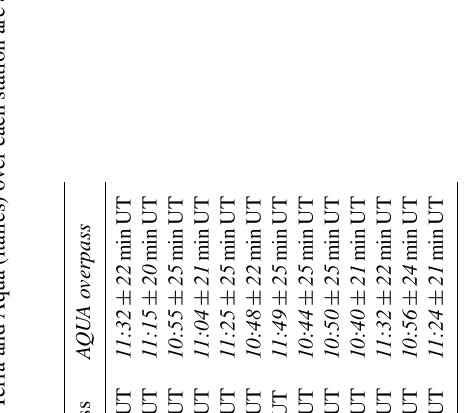
Figure 1. Eastern Mediterranean map with the nine subregions se- lected for the generalization of our results and the location of the AERONET stations used for the validation of MODIS satellite data. The nine subregions are NBL (northern Balkans land), SBL (south- ern Balkans land), ANL (Anatolia land), NAL (northern Africa land), BSO (Black Sea oceanic), NWO (northwestern oceanic), SWO (southwestern oceanic), NEO (northeastern oceanic) and SEO (southeastern oceanic). The full names and the geolocation of the 13 AERONET stations appearing in the map are available in Table